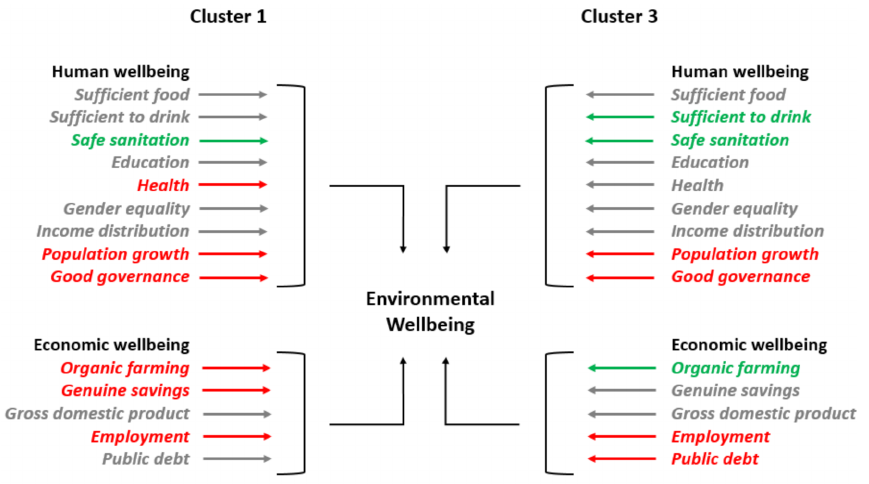
Figure 8. Comparison between clusters regarding the influence of human and economic wellbeing on environmental wellbeing. Source: Authors’